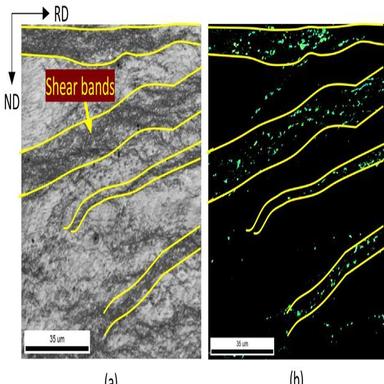
Cold-rolled grains having the orientation with shear bands containing Goss sub-grains. (a) Distribution of the image quality parameter (that describes the quality of an electron backscatter diffraction pattern) with a step of 0.1 mm and (b) pixels belonging only to Goss orientation (green). Sample HR5 after second cold rolling CR2. (For interpretation of the references to colour in this figure legend, the reader is referred to the Web version of this article.)